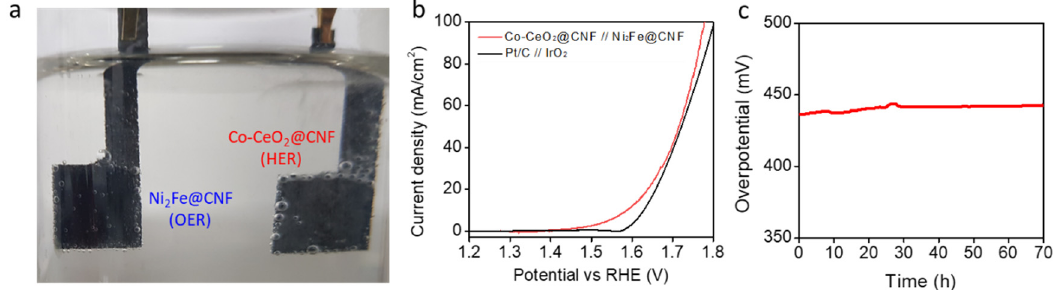
Figure 4. Electrochemical performances of the electrolyzer with Co-CeO 2 @CNF // Ni 2 Fe@CNF for overall water splitting. ( a ) Optical image of the Co-CeO 2 @ // Ni 2 Fe@CNF electrolyzer. ( b ) Overall water splitting characteristics of the Co-CeO 2 @CNF // Ni 2 Fe@CNF and IrO 2 // (Pt / C) electrolyzers measured in a two-electrode configuration in the range of 1.8 to 1.2 V at a scan rate of 1 mV / s in a 1-M KOH solution. ( c ) iR -uncorrected chrono-potentiometric curve of the Co-CeO 2 @CNF // Ni 2 Fe@CNF electrolyzer at a steady-state current density of 10 mA / cm 2 in a 1-M KOH